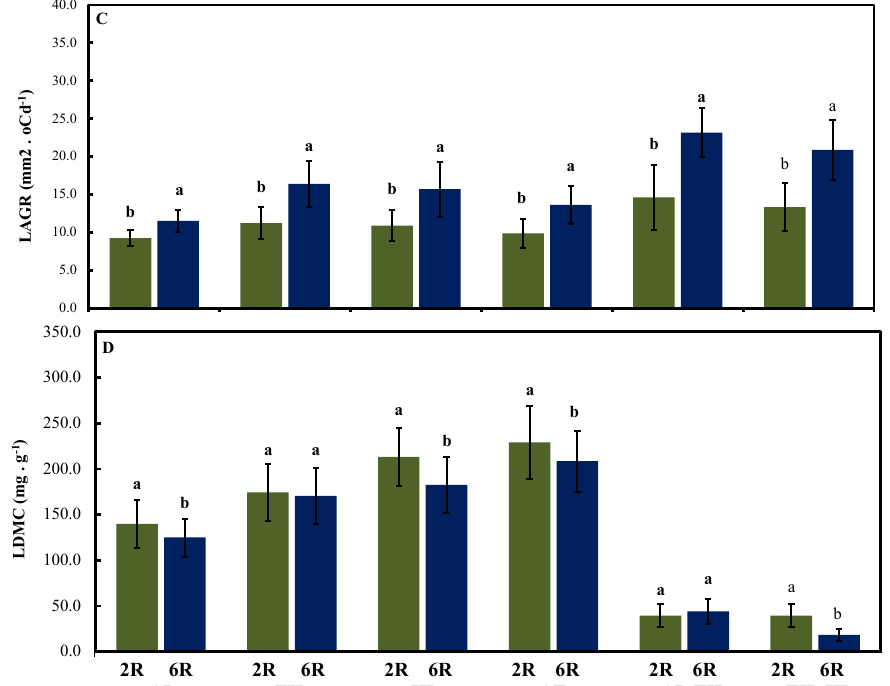
Figure 4. Leaf growth rate per main culm at different stages and phases for two- and six-rowed barley averaged across all growth conditions. ( A ) Leaf fresh weight growth rate (LFWGR); ( B ) leaf dry weight growth rate (LDWGR); ( C ) leaf area growth rate (LAGR); and ( D ) leaf dry matter content (LDMC). The same letters at each developmental stage are not significantly different at p ≤ 0.05 according to the Least Significant Difference. Bars indicate standard deviation ( n = 42 (14 accessions × 3 replicates) and 54 (18 accessions × 3 replicates) for two- and six-rowed barley, respectively). AP: awn primordium,